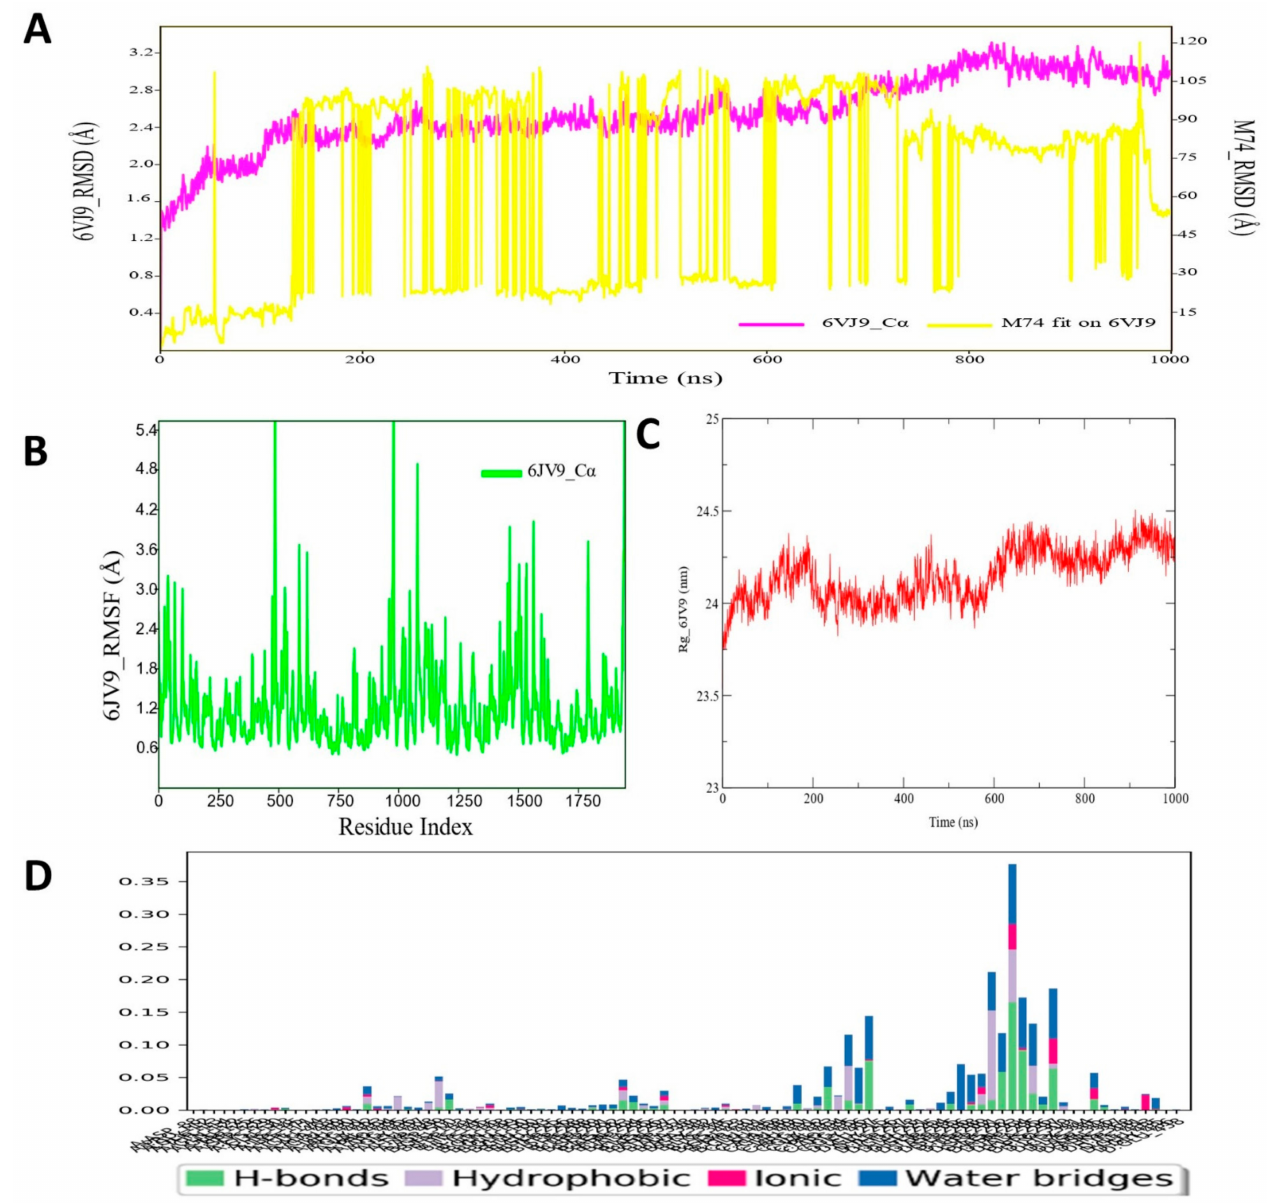
Figure 3. ( A ) RMSD profile of CRMP2 (6JV9) protein backbone and compound M74 during 1000 ns simulation span; ( B ) RMSF profile of CRMP2 (6JV9) protein backbone during 1000 ns simulation span; ( C ) RoG profile of CRMP2 (6JV9) protein backbone during 1000 ns simulation span; ( D ) illustration of the CRMP2 (6JV9)–M74 contacts or interactions map monitored during 1000 ns simulation